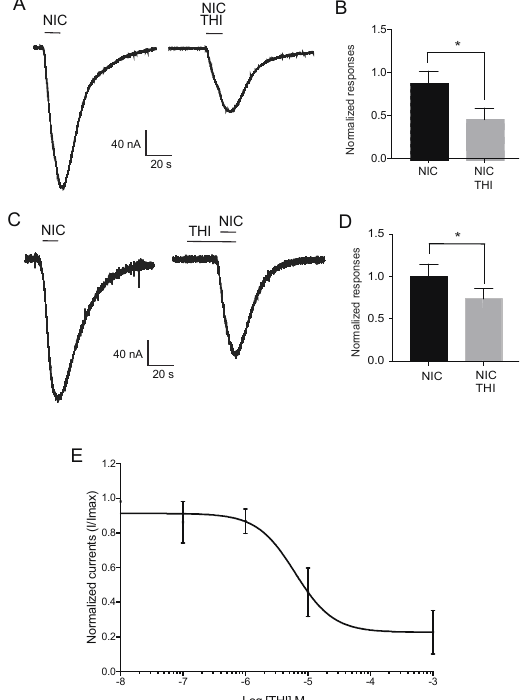
Figure 4. Effects of co-application or pretreatment of THI on nicotine-evoked currents. ( A , B ) show the effect of co-application of 10 µ M THI on currents induced by bath application of 10 mM nico- tine. ( C , D ) illustrate currents-evoked by 10 mM nicotine after pretreatment with 10 µ M THI. In all histograms, data are mean ± SEM, n = 6 and * p < 0.05. Note that no significant difference was found when in the THI effects with or without 5 min pretreatment. While, ( E ) represents the inhibition-response curve under co-application of THI with 10 mM nicotine. Each point represents n =